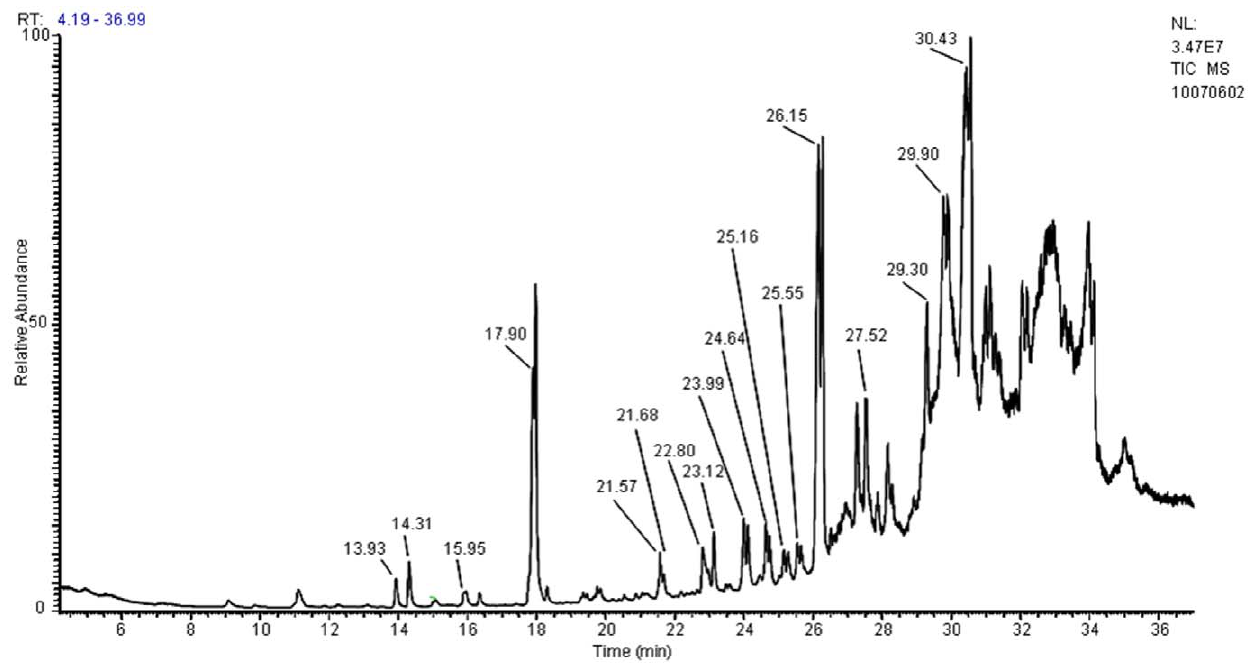
Figure 2. GC-MS TIC traces of the Dufour gland extracts of Crematogasterstriatula by electronic impact ionization (EI): injection of 1 m L of hexanic extract. The major double peak at a retention time of 26.15 minutes, for example, corresponds to two isomers of compound C21H30O3 (m/z 330). The trace shows other double or single peaks corresponding to C16 at C23 compounds.